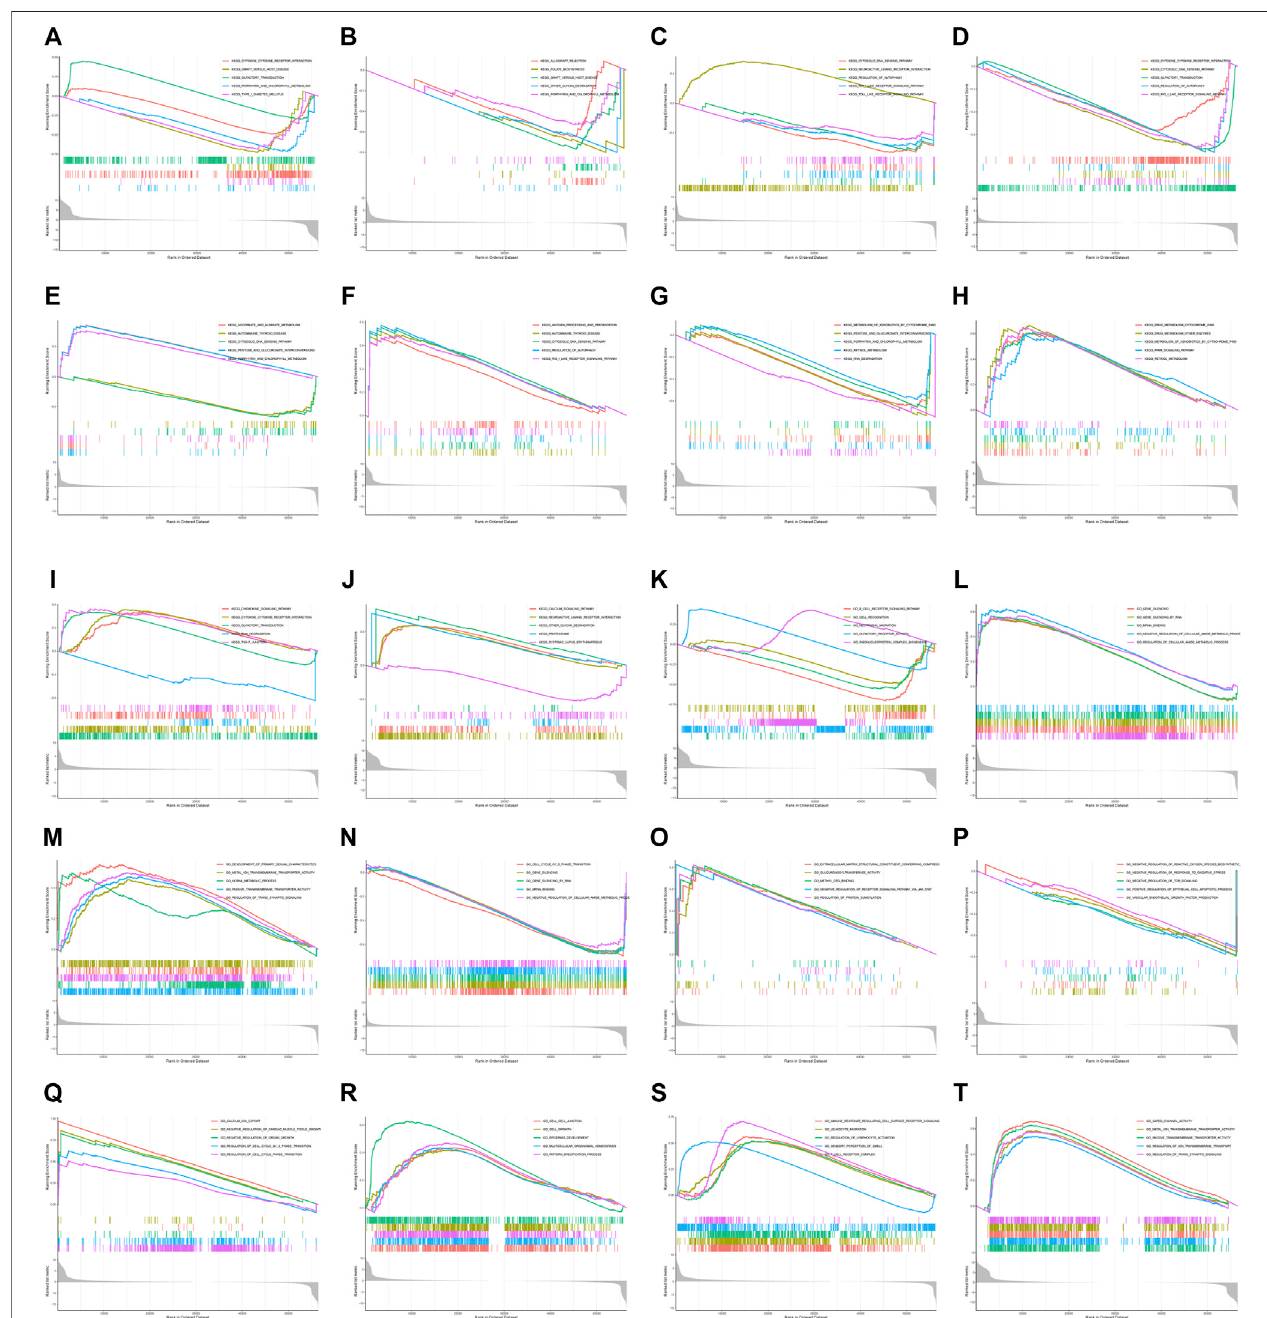
FIGURE 8 | (A – J) GO functional annotation of DUXAP8 gene in ACC, BLCA, HNSC, LUSC, OV, PAAD, PCPG, TGCT, THCA, and UVM. (K – T) KEGG pathway analysis of DUXAP8 gene ACC, BLCA, HNSC, LUSC, OV, PAAD, PCPG, TGCT, THCA, and UVM. Different color curves indicate that the DUXAP8 gene regulated different functions or pathways of different cancers, with peaks of curves upward indicating positive regulation and peaks of curves downward representing negative regulation.